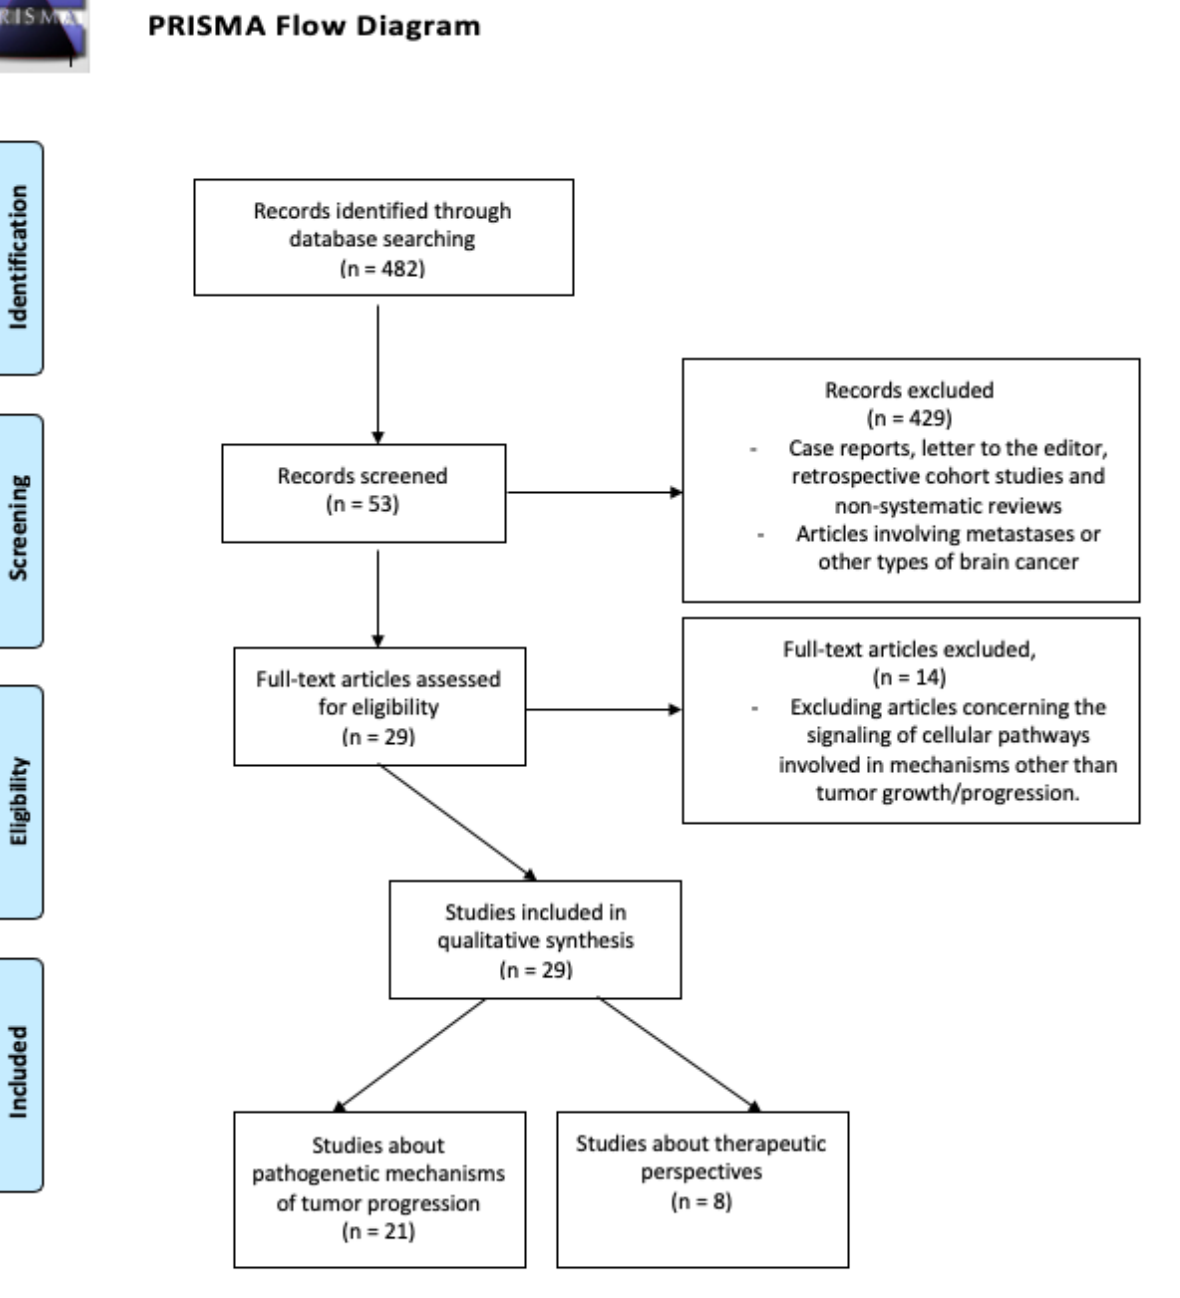
Figure 1. Flow diagram showing the article selection process.